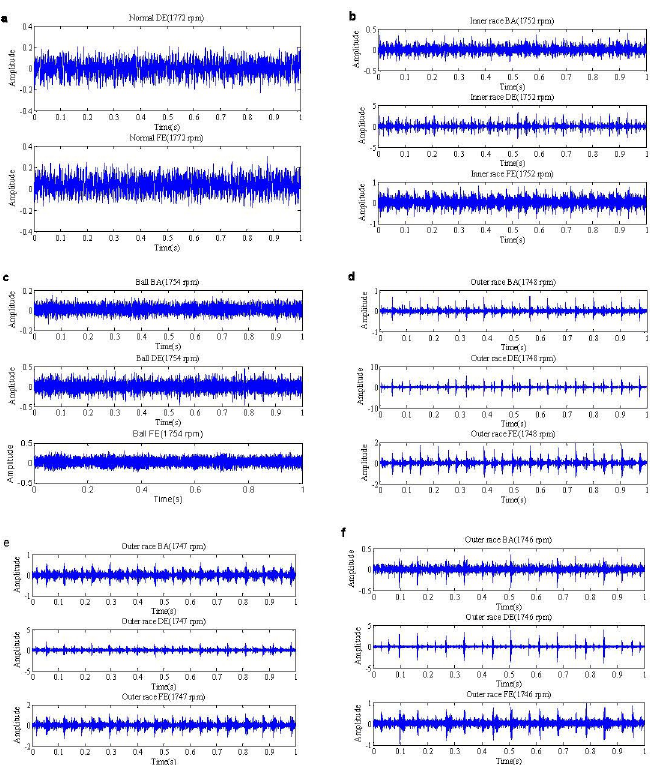
Fig 2. The waveforms of the normal and drive end bearing fault data. (a. The waveforms of the normal DE and FE data; b. The waveforms of the inner race BA, DE and FE fault data; c. The waveforms of the ball BA, DE and FE fault data; d. The waveforms of the outer race BA, DE and FE fault data position relative to load zone centered at 6:00; e. The waveforms of the outer race BA, DE and FE fault data position relative to load zone orthogonal at 3:00; f. The waveforms of the outer race BA, DE and FE fault data position relative to load zone opposite at 12:00.